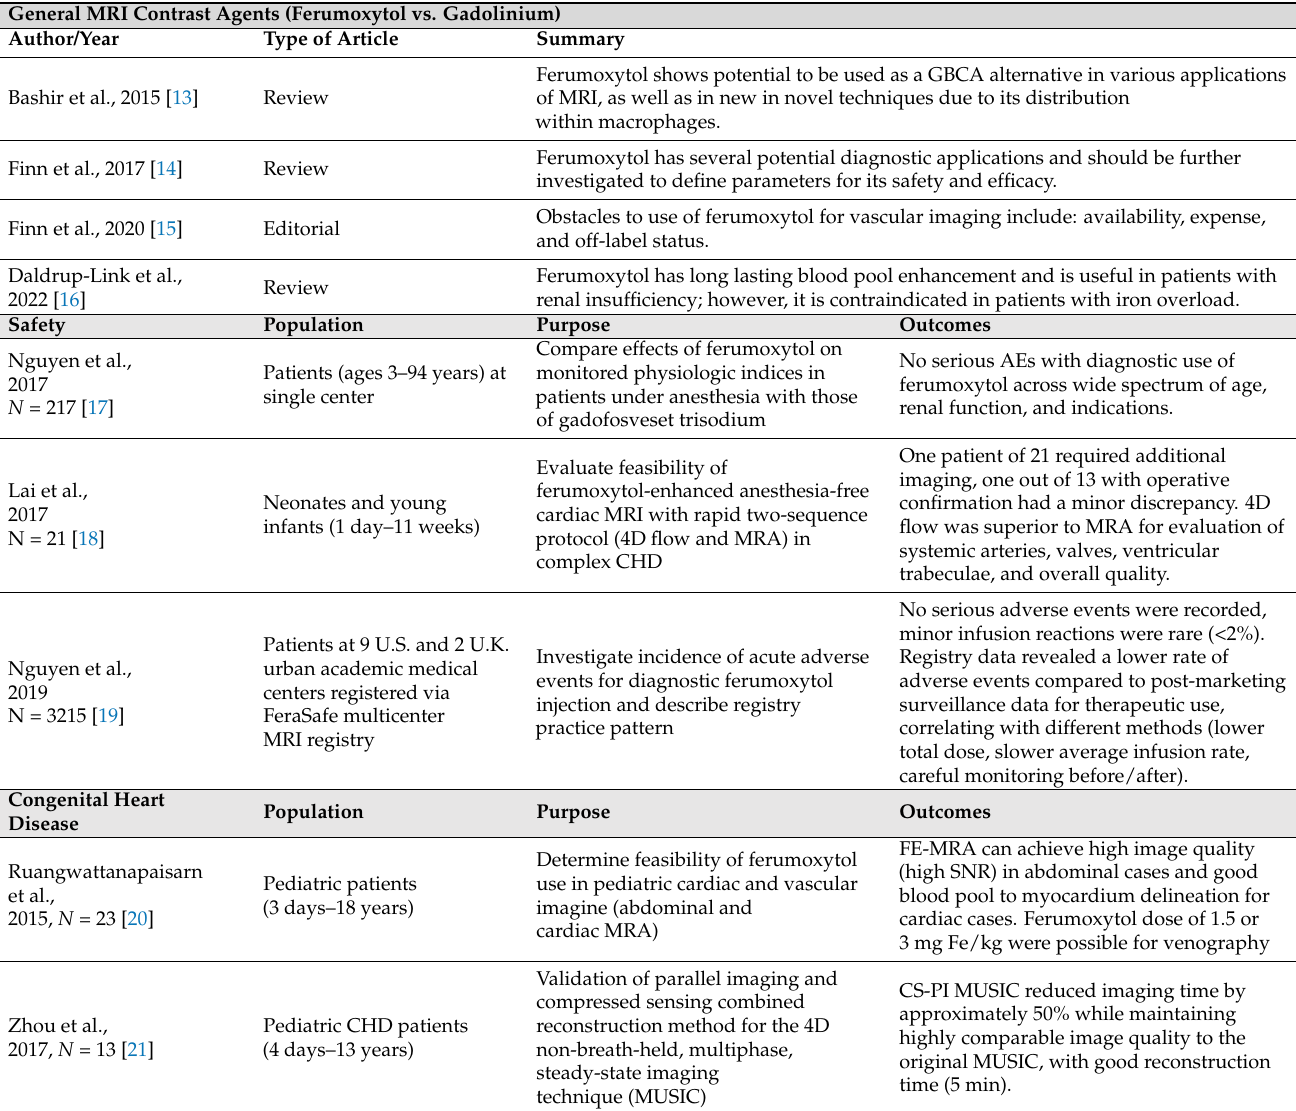
Table 1. Select References Related to Off-Label Diagnostic Use of